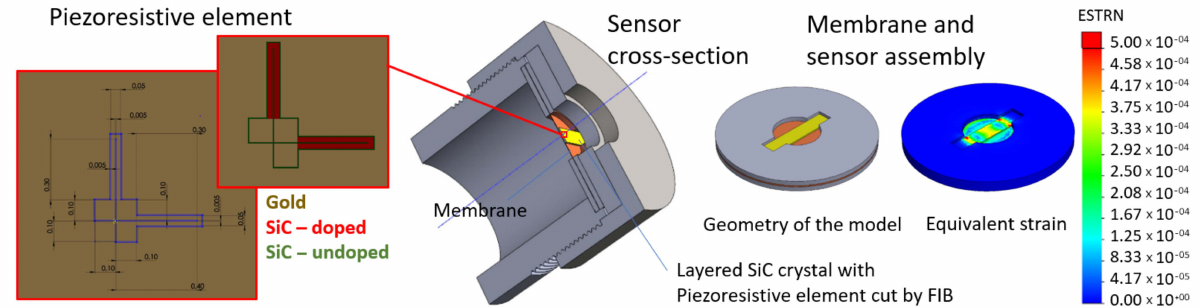
Figure 6. The model of the pressure sensor construction and the designed geometry of the piezoresistive